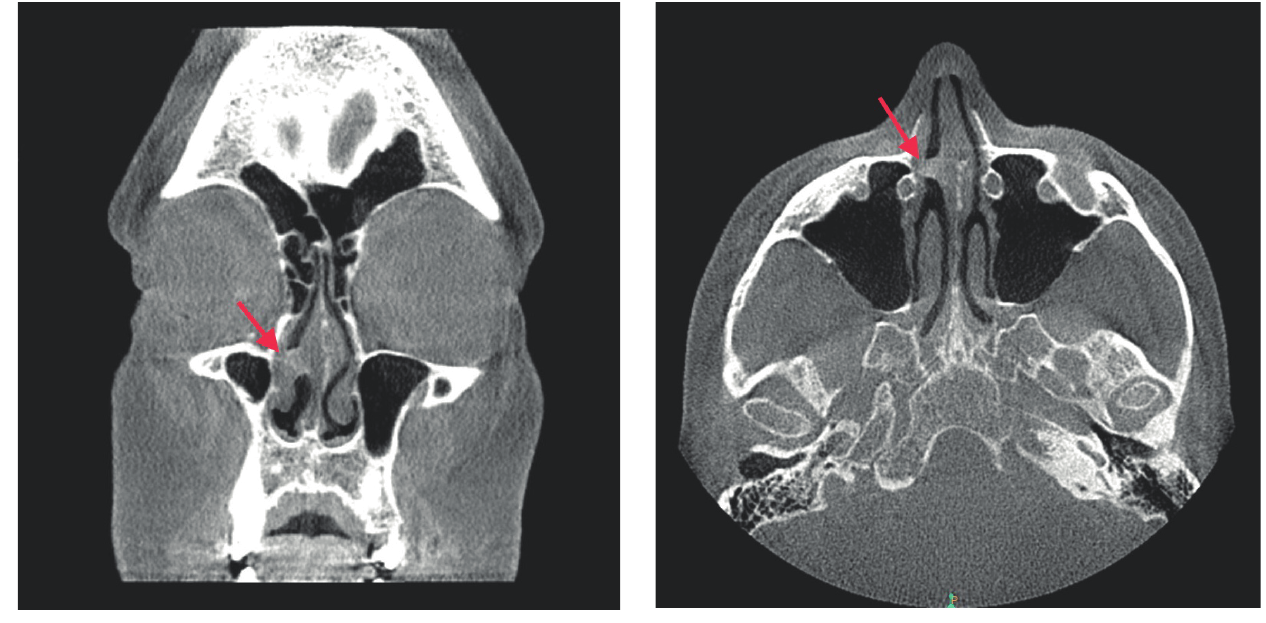
Figure 2. Non-contrast axial computed tomography (CT) image showing a right nasal septal mass (depicted by the red arrow).